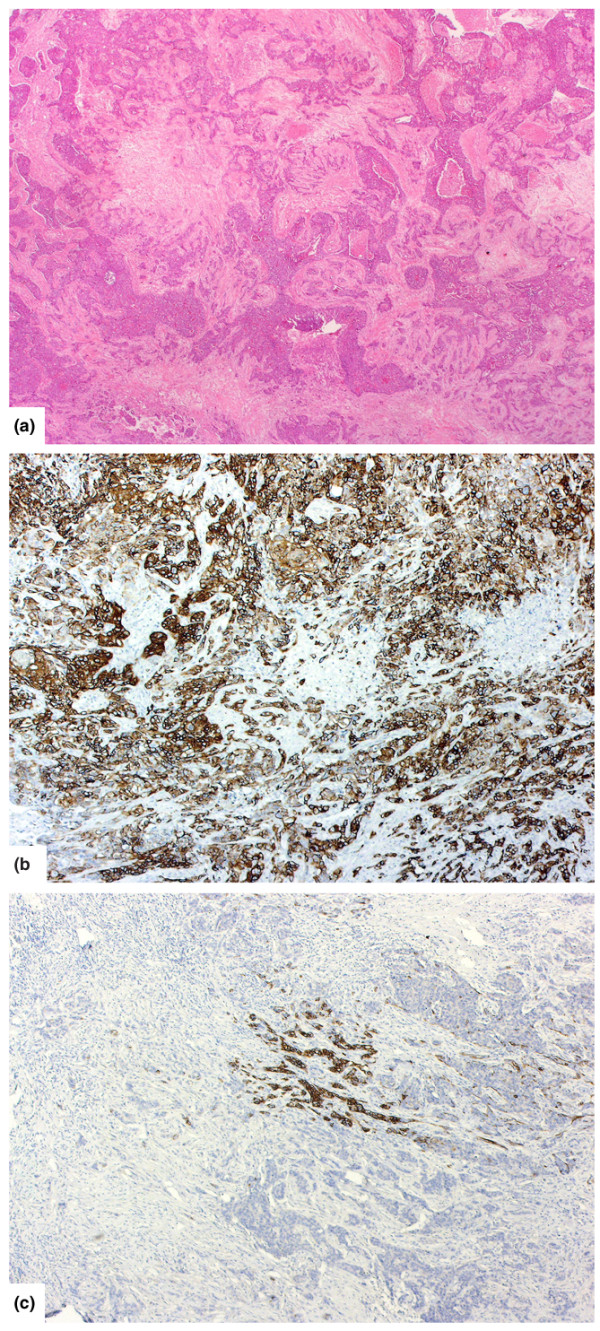
Histological appearance of basal tumours and CK14 expression patterns. (a) Typical histological appearance of a basal breast carcinoma (haematoxylin and eosin). (b) CK14 expression: a basal tumour with basal keratin expression in almost every tumour cell (diffuse staining pattern). (c) Another basal tumour with only a minority of tumour cells showing expression (focal staining pattern).